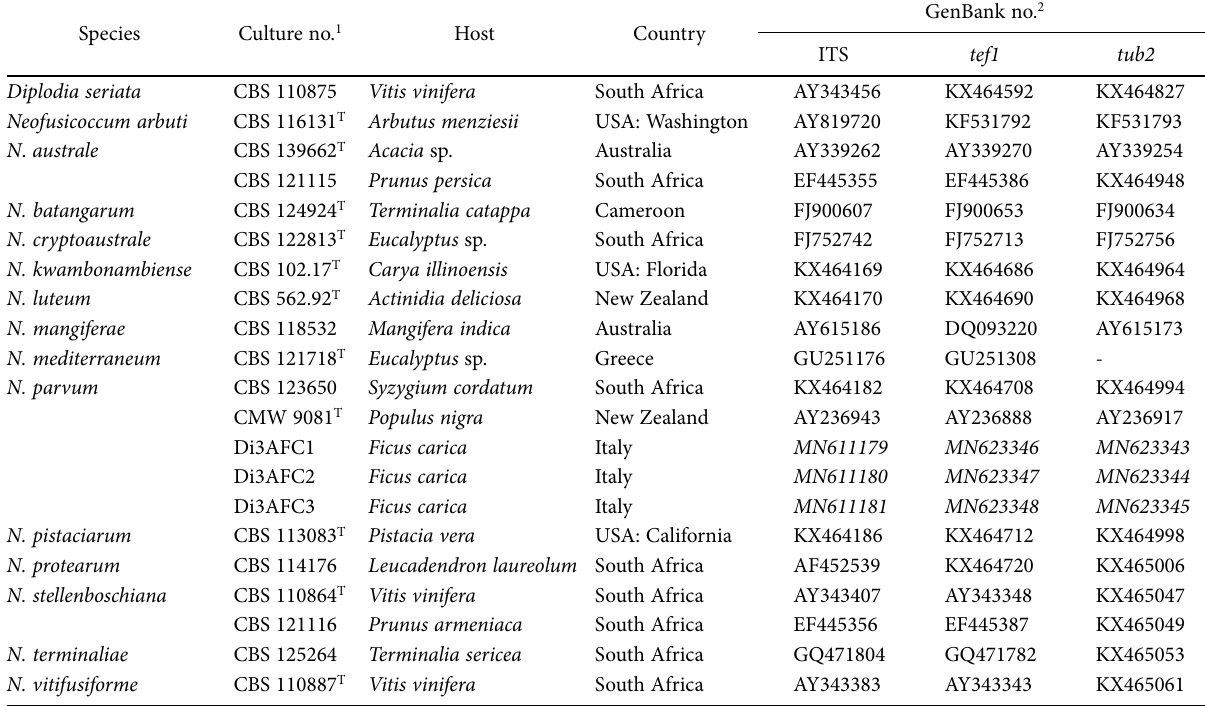
Table 1. Collection details and GenBank accession numbers of isolates included in this